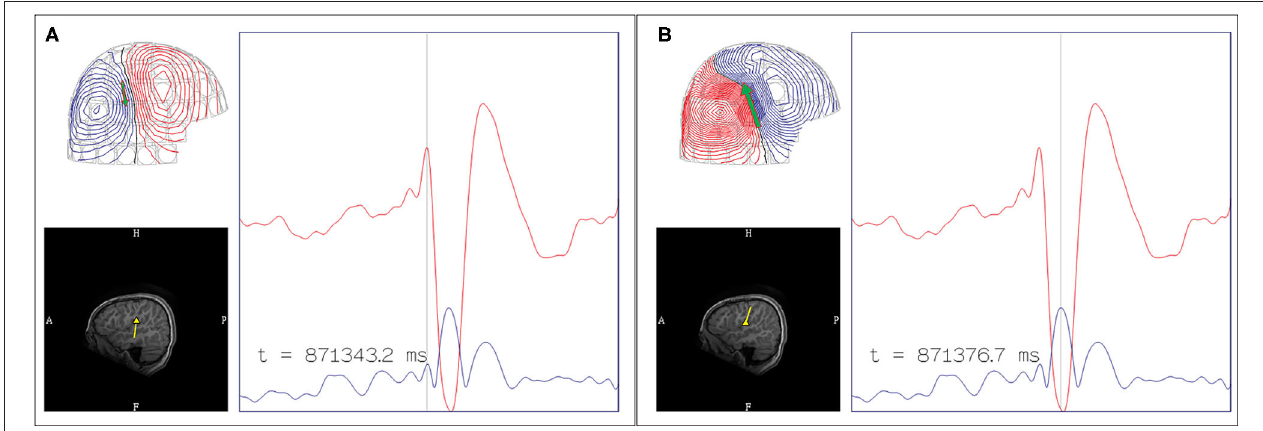
FIGURE 13 | Multiphasic MEG signal with phase-dependent orientation. (A) The early peak of lower amplitude was occasionally observed, with dipole oriented inferiorly, likely represents the initial depolarization of deeper laminae. (B) The later peak of higher amplitude was a more consistently observed, with dipole oriented superiorly suggestive of frontal operculum localization. Although the area of dipole origin was consistent, the appearance of multiphasic MEG discharges across major sulci can affect the application of orientation-based localization, given that the orientation is dependent of which phase of the discharge was modeled. EEG can assist in determining more pertinent depolarization in these circumstances.